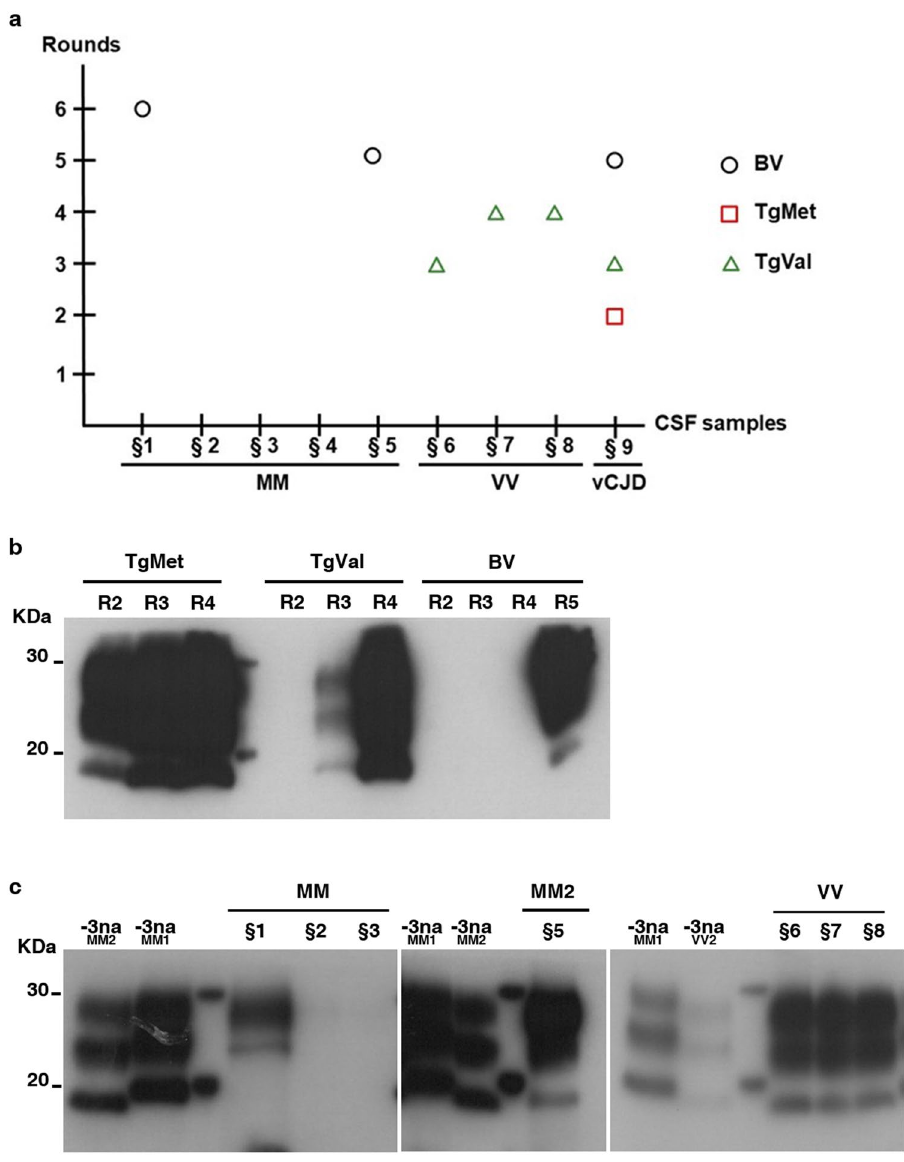
Figure 4. Detection of PrP TSE in the CSF of CJD patients. CSF samples from 8 sCJD patients (§1–§8) and 1 definite vCJD patients were serially amplified by PMCA. The PrP TSE signal was assessed by means of western blot analysis after proteinase K digestion using 9A2 antibody. For each sample, 20 µL of the product were loaded onto the gel. R refers to the number of rounds. M indicates the typical molecular mass of PrP res in the range of 20–30 kDa. ( a ): Representation of the results according to CSF sample genotypes and number of rounds; ( b ): vCJD amplification in TgMet, TgVal and BV substrates; ( c ): sCJD amplification: MM subtypes in BV substrate; VV subtype in TgVal substrate. − 3na MM2/MM1/VV2 refer to non-amplified material (no PMCA) obtained from the 10 −3 dilution (w/v) of the initial infectious brain samples from MM2, MM1 and VV2 subtypes,